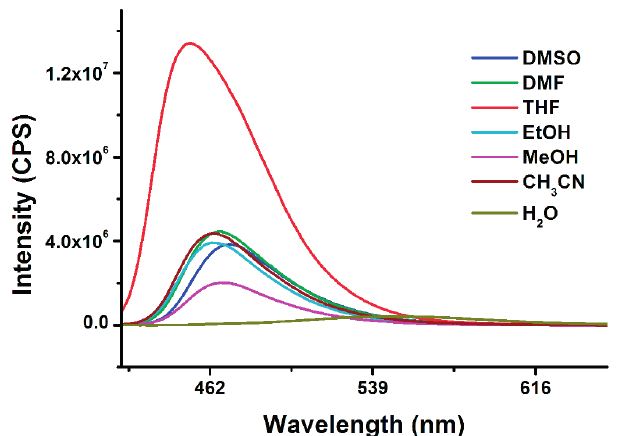
Figure 1. The fluorescence emission spectra of Rh-C (5 μ M) in different solvents. ( λ ex = 400